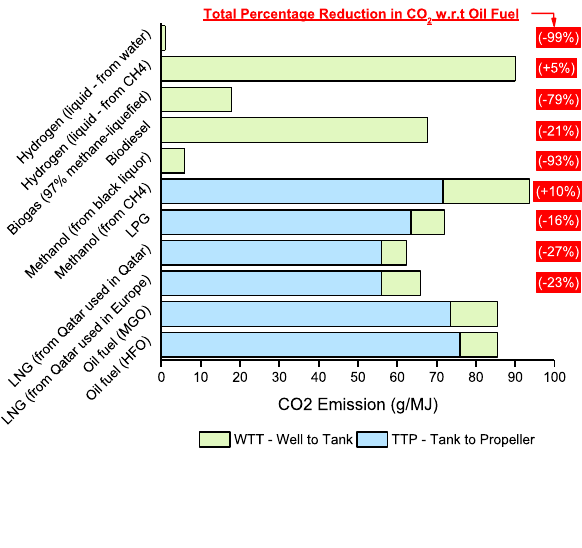
Fig. 27 Projected annual CO emissions from shipping sec- tor, data derived from